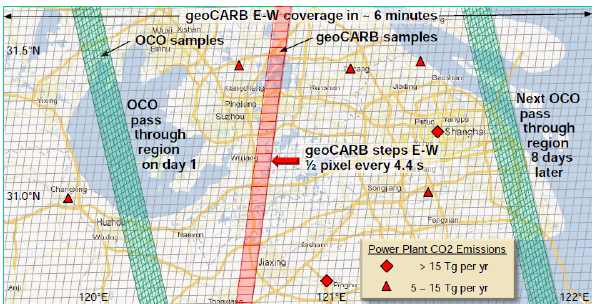
Fig. 2. GeoCARB complements the fine spatial resolution of OCO- 2 with contiguous, rapid temporal coverage of any region in the field of